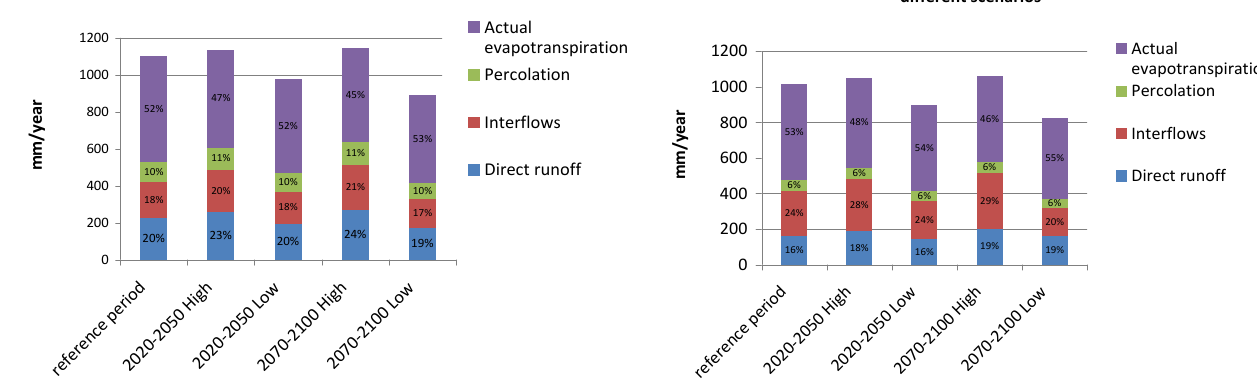
Fig. 6. Water balance for the Vesdre and the Lesse sub-catchments for the different scenarios and time slices. The changes in MAM7 values are presented in Table